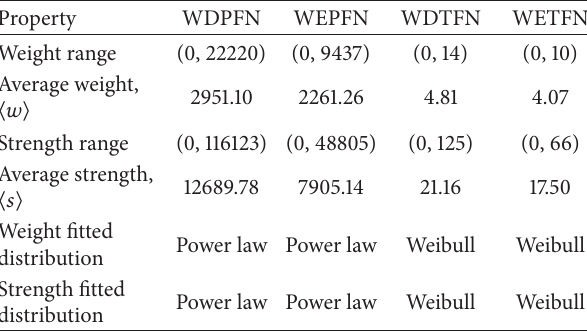
Table 2: Statistical properties of the PFN and TFN on weekday and weekend.